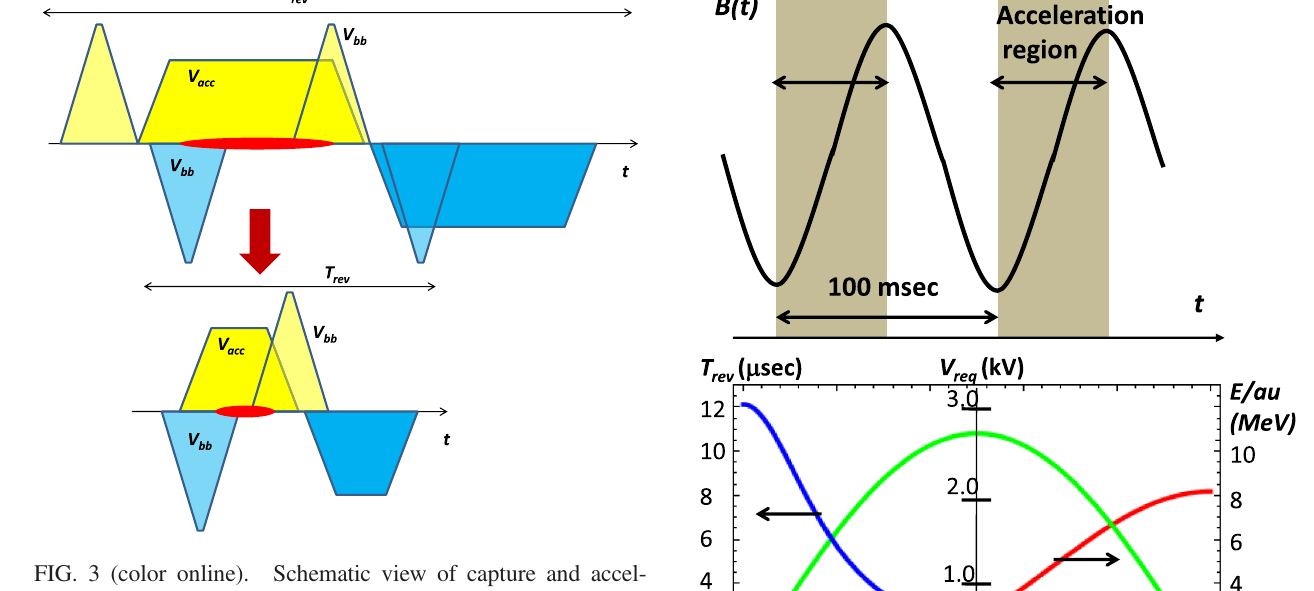
(green), revolution req